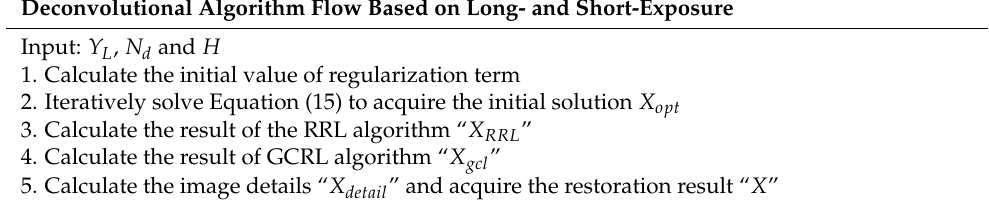
Table 3. Deconvolutional algorithm flow based on long- and short-exposure. Deconvolutional Algorithm Flow Based on Long- and Short-Exposure Input: Y L , N d and